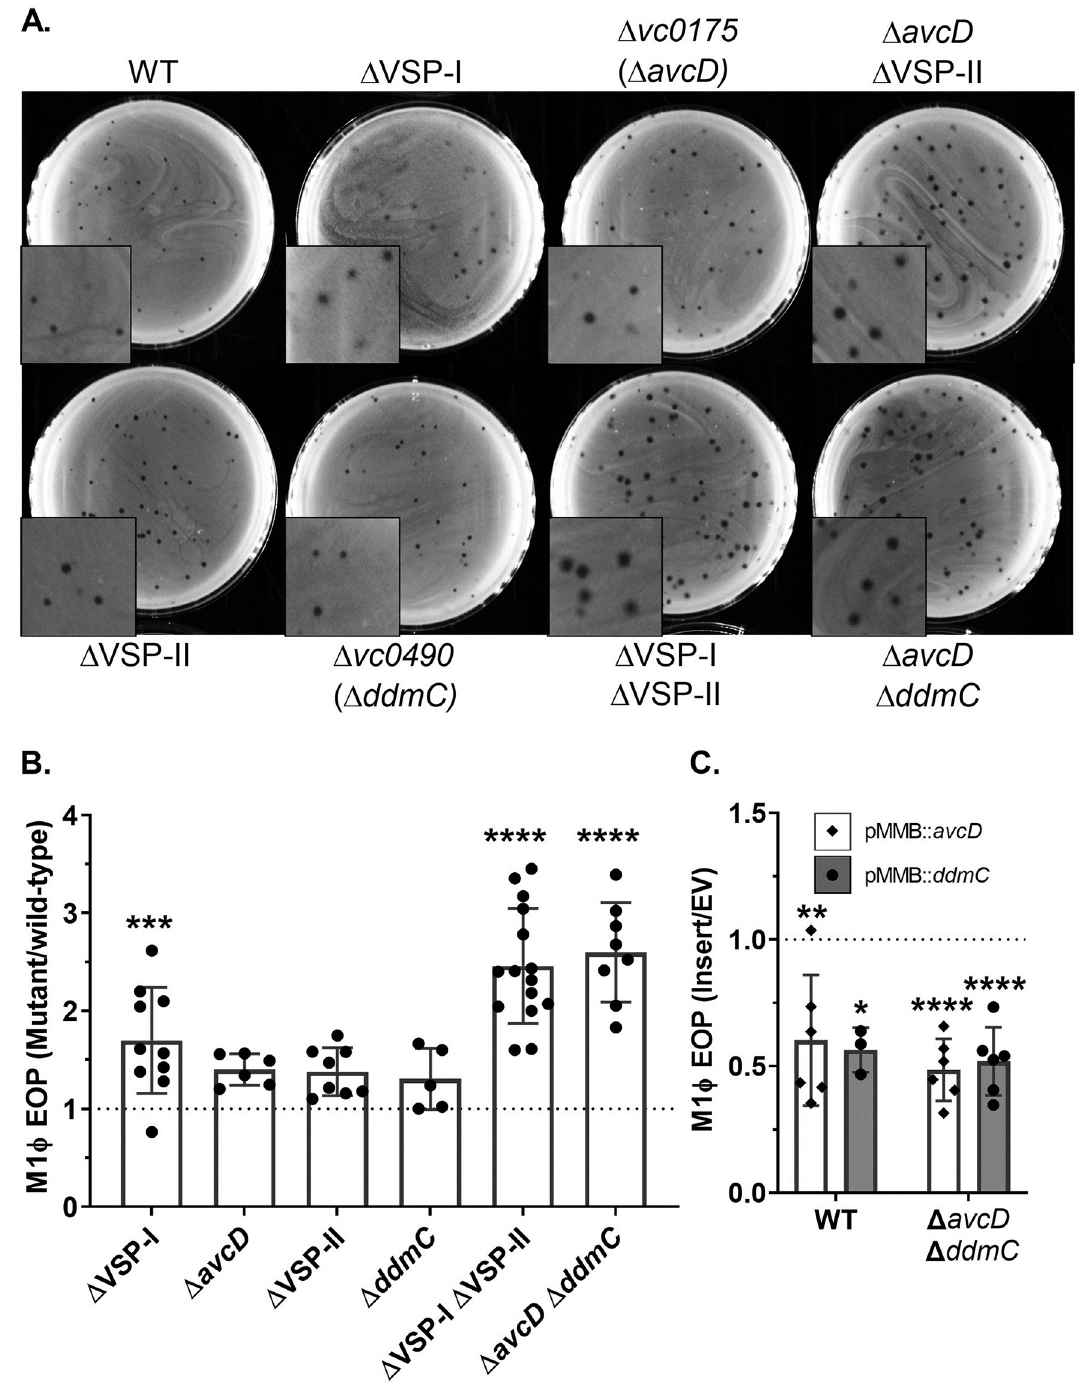
Fig 2. AvcD (VSP-I) and DdmC (VSP-II) inhibit phage plaque formation. (A) Representative images of M1 F plaqued on 0.7% LB agar with various hosts. (B) Efficiency of plating (EOP) of M1 F on the indicated hosts vs WT. EOP was calculated by dividing the number of plaques obtained from the indicated mutant strain by the plaques obtained from the parental VSP + strain (WT). (C) EOP of different V . cholerae strains expressing vc0175 (avcD) or vc0490 ( ddmC) from a plasmid. Strains containing plasmid expressing avcD (white bars/diamonds) or plasmid expressing ddmC (grey bars/circles), or plasmid with no insert (EV), on the low copy number plasmid pMMB67eh were infected with M1 F under inducing conditions in either the WT or Δ avcD Δ ddmC background as indicated in the figure. EOP was calculated by dividing the number of plaques from the strains ectopically expressing either avcD or ddmC by the number of plaques from the strains carrying the empty vector. Significance was determined by one-way ANOVA with Dunnett’s